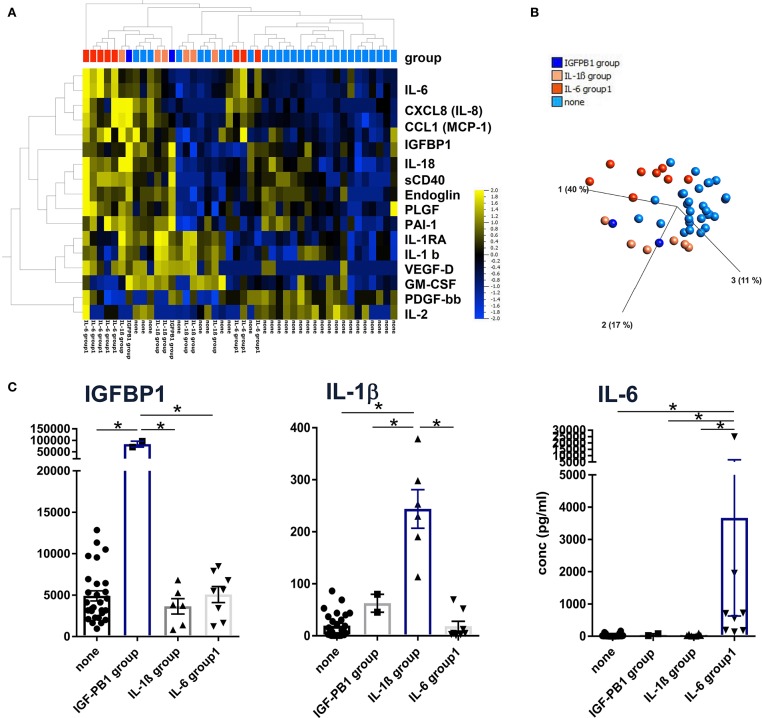
Definition of patient subgroups according to hierarchical clustering, principal component analyses. (A) Concentrations of 43 proteins from 44 perilymph samples were log-normalized with a threshold of 0.01 and filtered to p < 0.05 with q = 0.2 and visualized using hierarchical cluster and (B) PCA algorithms (Qlucore Omics 3.6 Software). Patient subgroups were defined by significantly high IGFBP1, IL-1b, and IL-6 concentrations, respectively, indicated by the color code shown in (B). (C) Descriptive statistics were applied to the four patient groups using raw protein concentrations and Kruskal-Wallis tests with p < 0.05 defined as significant and marked with an asterisk (*).